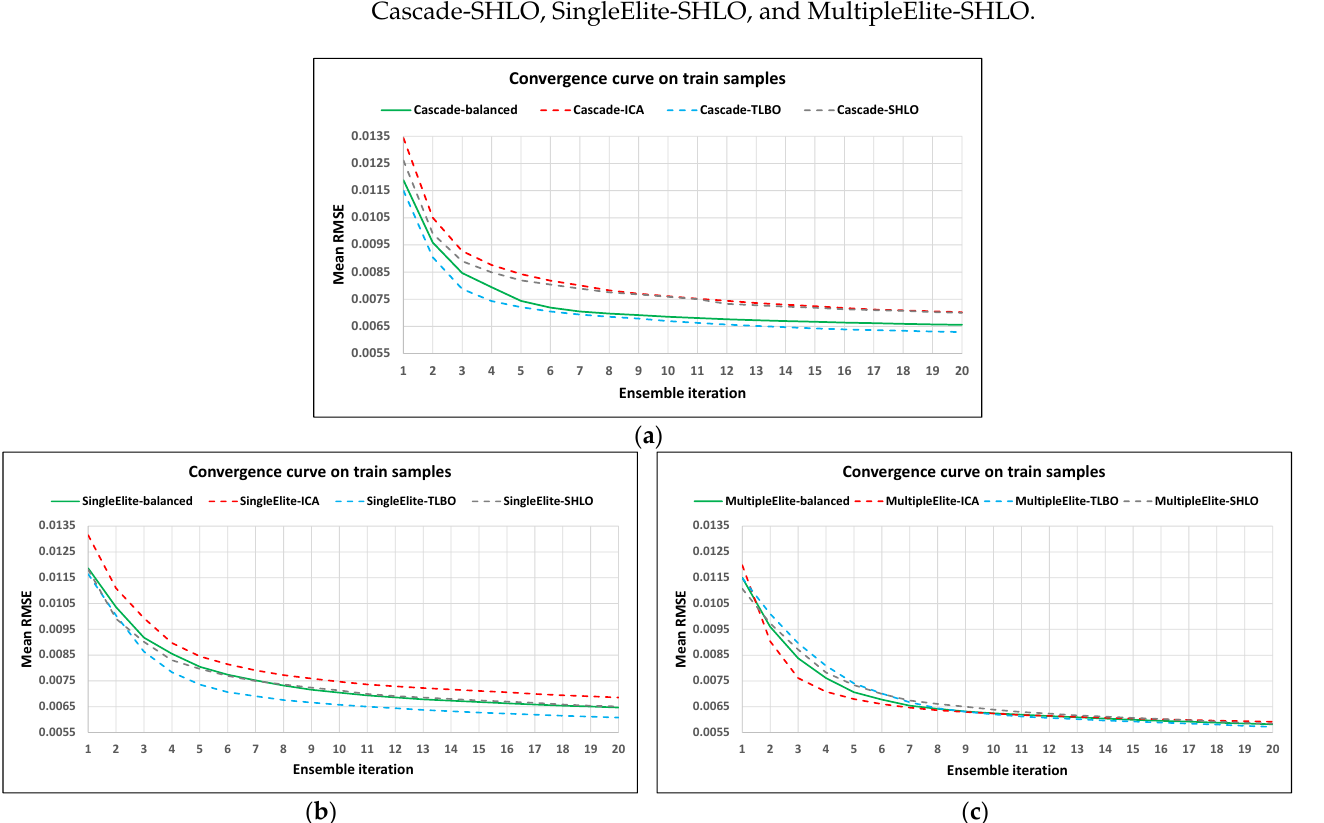
Figure 9. Convergence curve graphs of ensembles using a balanced number of iterations and an unbalanced number of iterations for weak optimizers: ( a ) cascade strategy; ( b ) single elite solution strategy; ( c ) multiple elite solutions strategy.